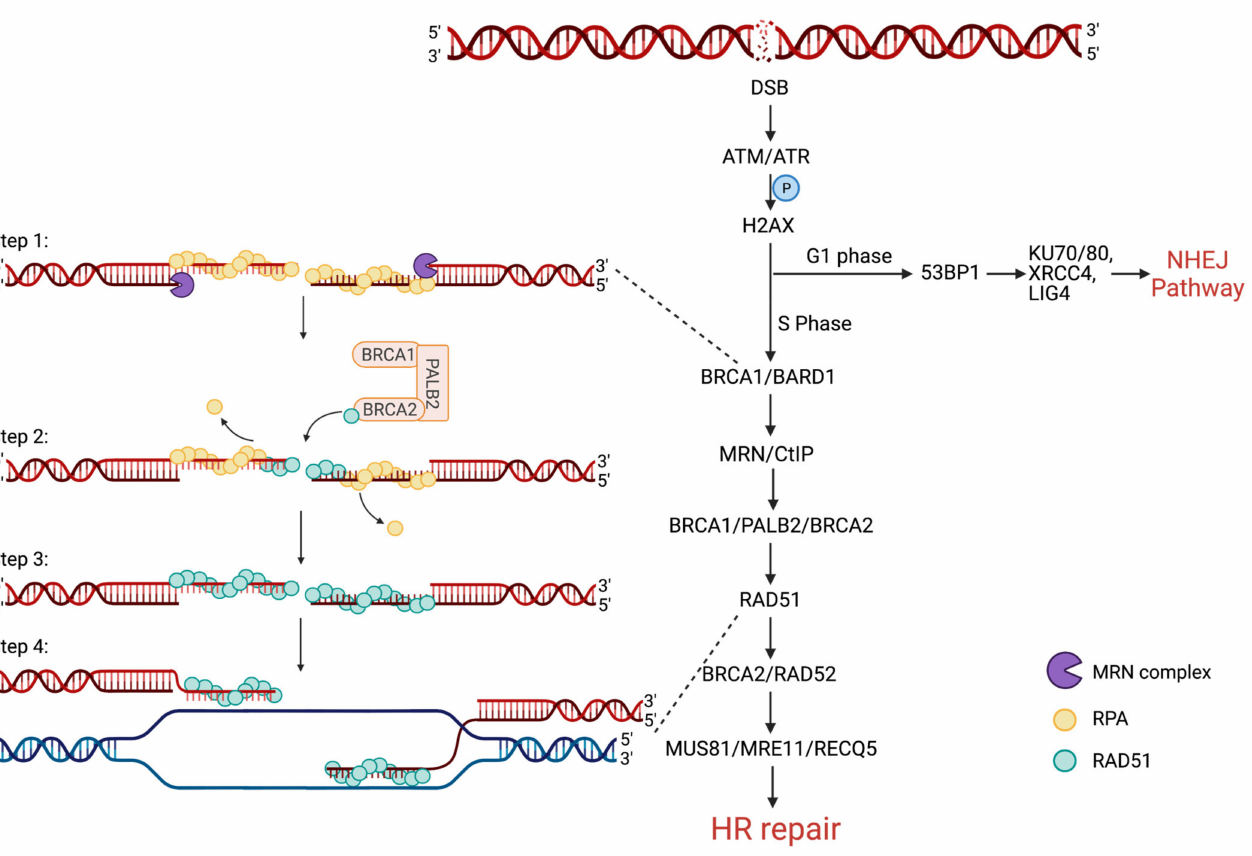
Figure 1. Representation of DNA double-strand break repair choice in the S/G2 phase between homologous recombination non-homologous end joining. The scheme details the steps leading homologous strand invasion and D loop formation. Step 1: 3 (cid:48) end resection by the MRN complex, RPA loading to protect single-strand DNA (ssDNA) from degradation. Step 2: BRCA2 is recruited by BRCA1/PALB2 and loads RAD51 onto the ssDNA overhangs and RPA is dislodged. Step 3: formation of the RAD51 Homopolymeric filament which wind around the ssDNA. Step 4: invasion of the homologous chromatid and search for homology in view of recombination and